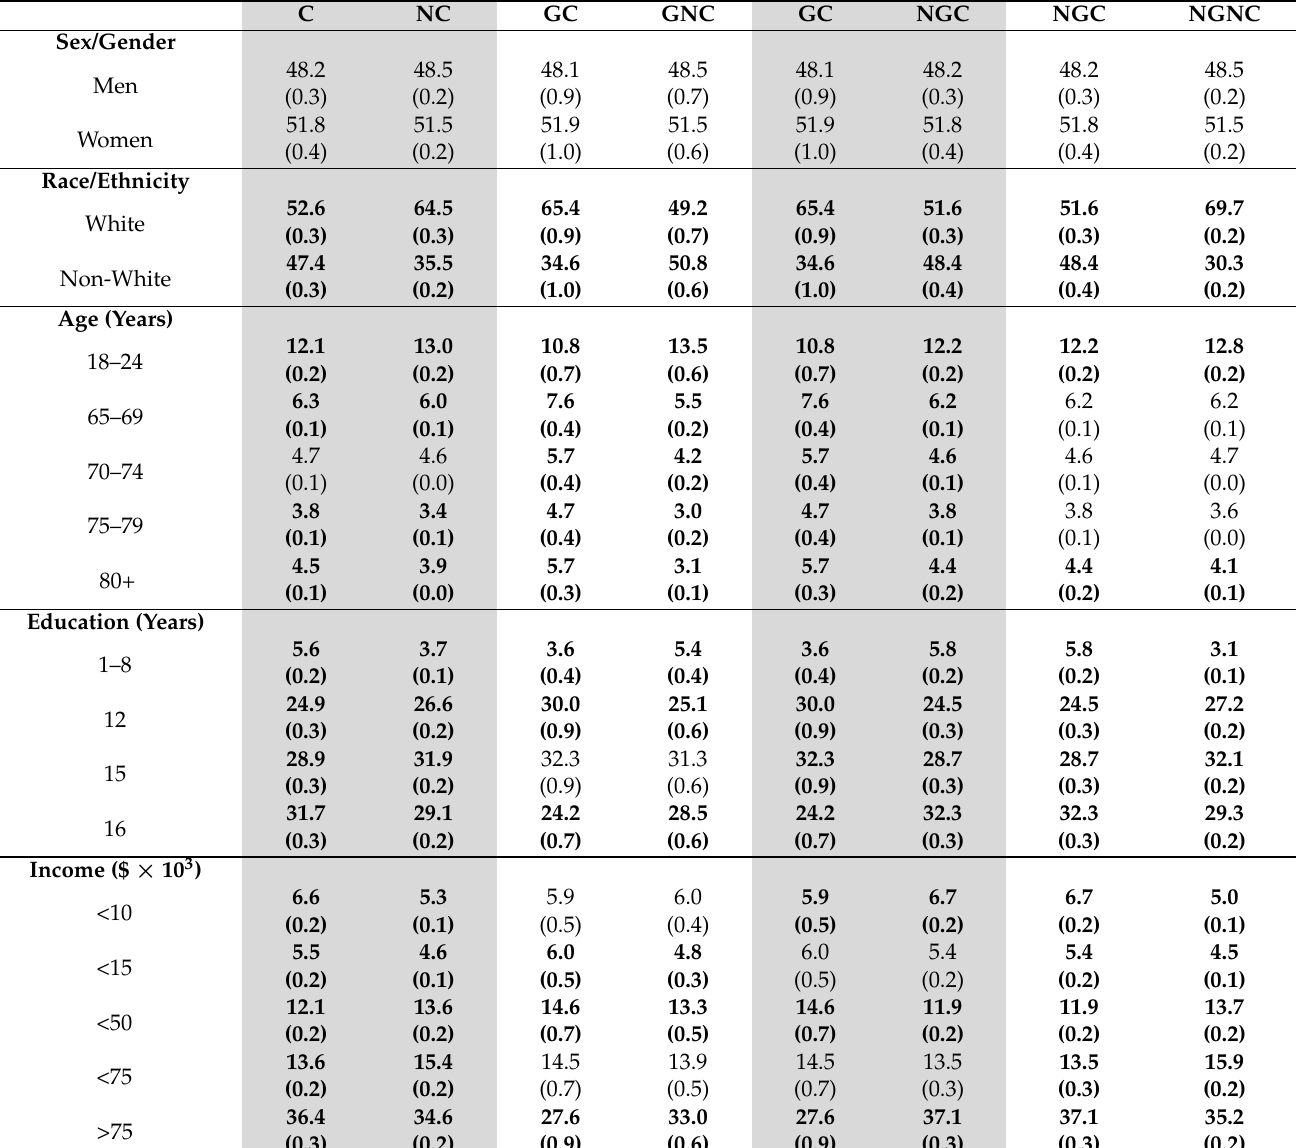
Table 8. Summary of demographic data, average over all five years. (See table notes for